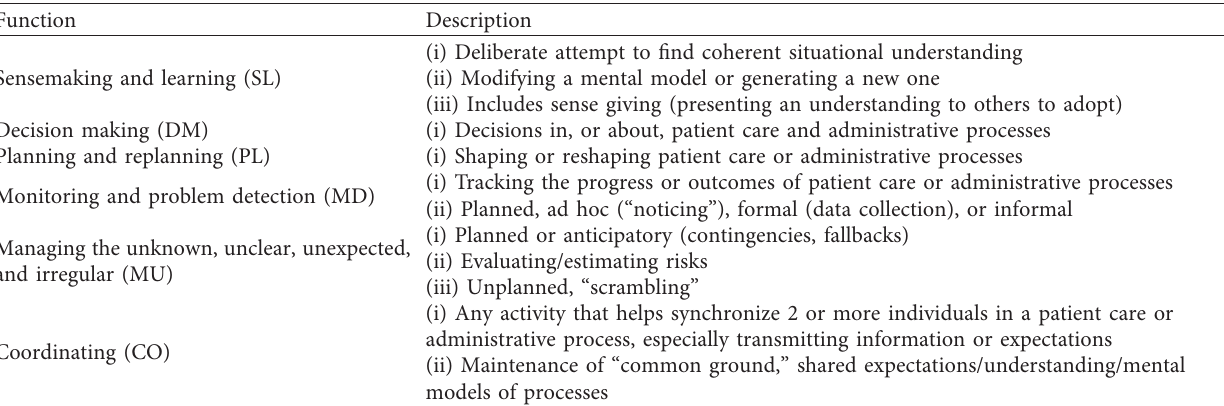
Table 2: Macrocognition framework.